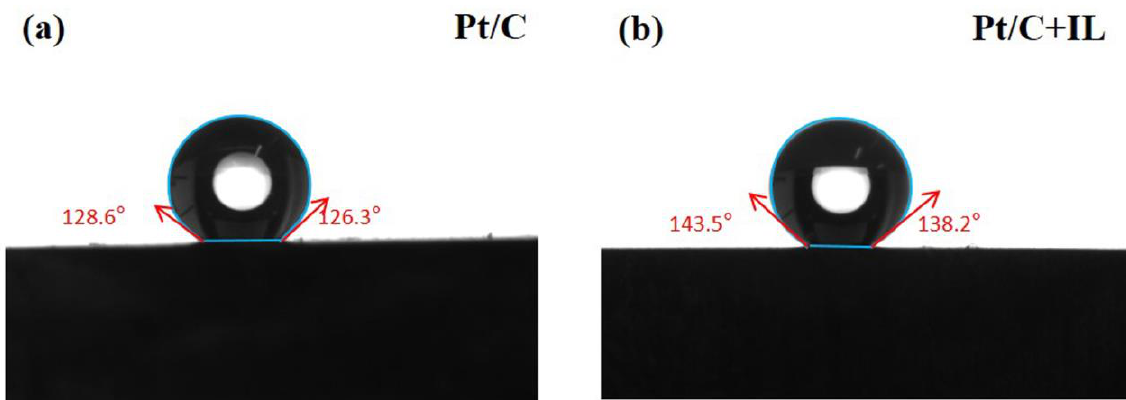
Figure 1. Contact angle of Pt/C ( a ) and Pt/C + IL ( b ).